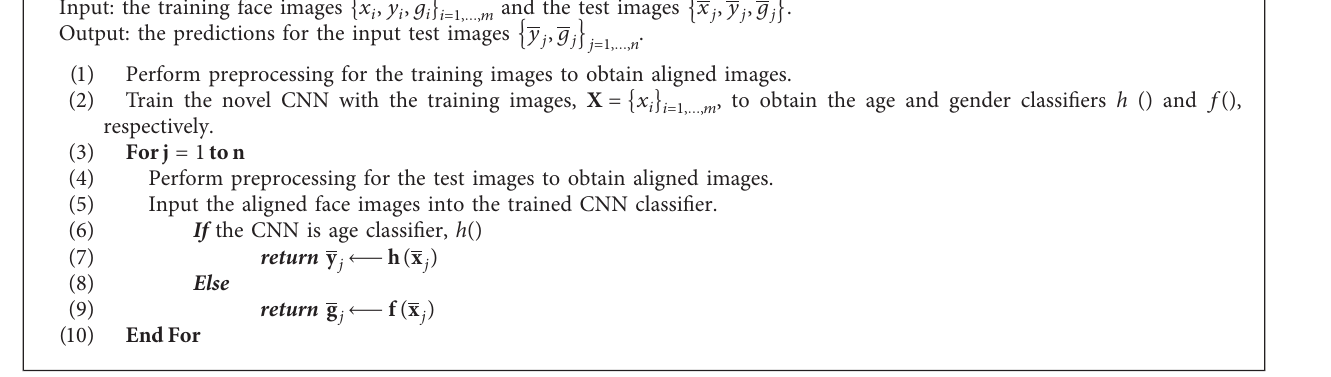
A LGORITHM 1: Algorithm for the age and gender classifiers.